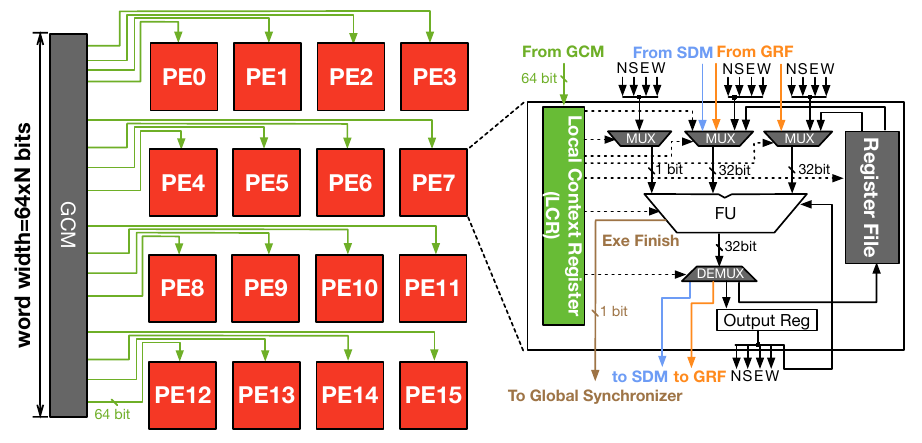
Figure 2. Organization of controlling